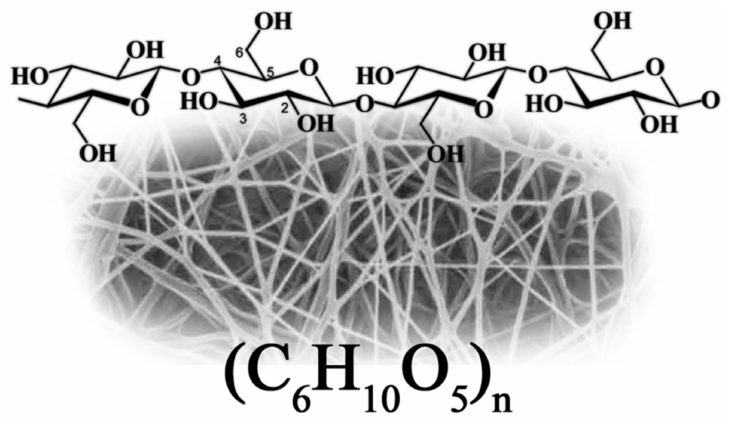
Figure 1. Chemical structure of Bacterial